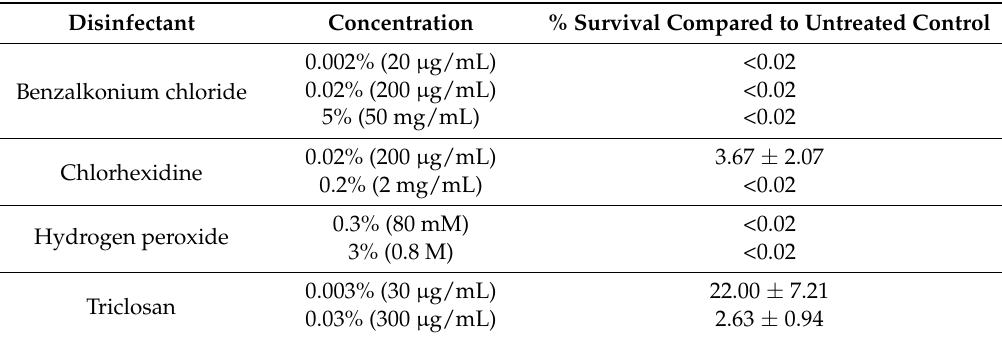
Table 2. Survival of phage phiIPLA-RODI in the presence of disinfectants. Disinfectant Concentration % Survival Compared to Untreated Control Benzalkonium